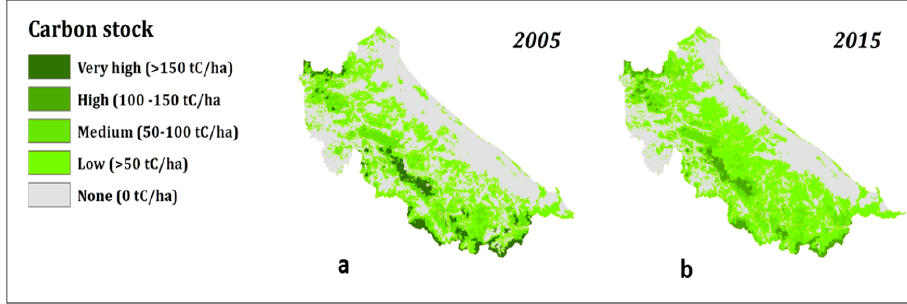
Figure 5. Distribution of carbon stock (tC / ha) across the study area. ( a ) Carbon stock in 2005; ( b ) carbon